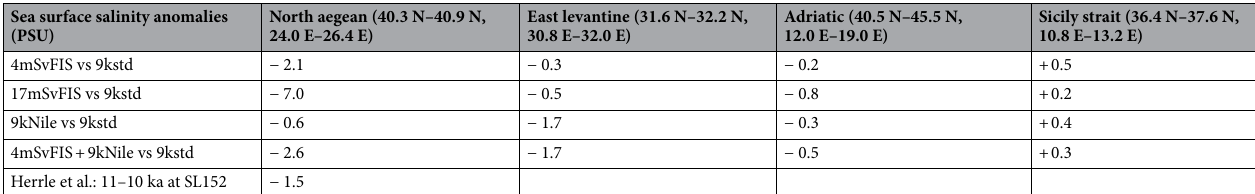
Table 1. Values of SSS (in PSU) anomaly for each ORCM experiments (vs “9kstd”), and 11 vs 10 ka SSS anomaly at SL152 15